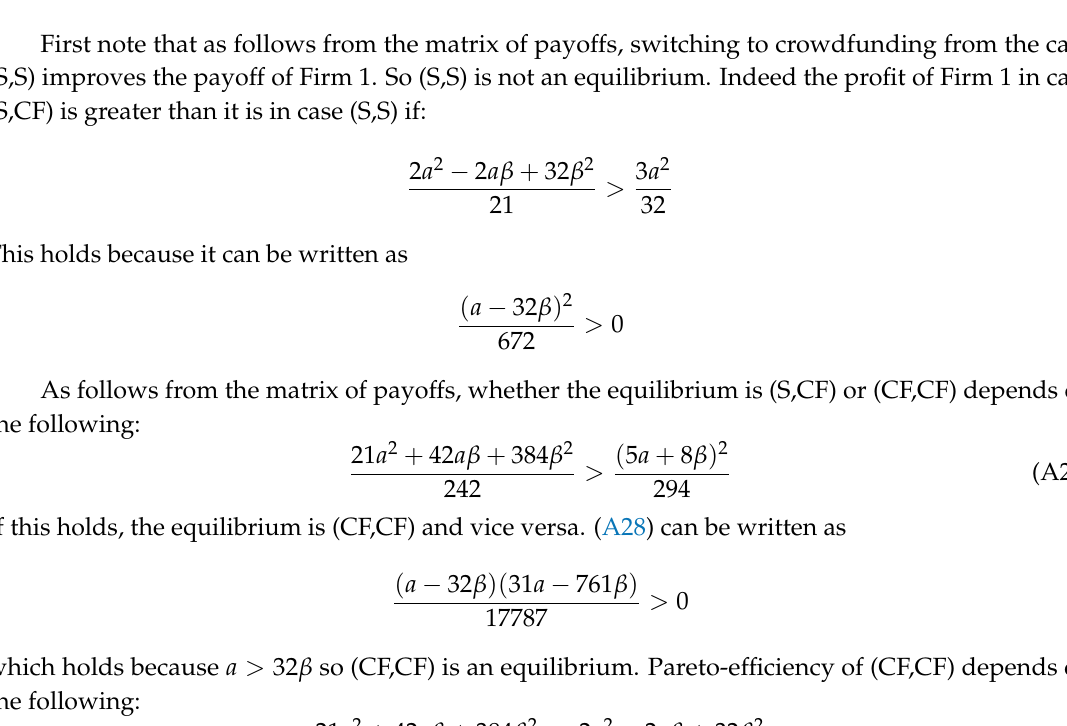
Figure A4. Matrix of payoffs in Cournot duopoly with